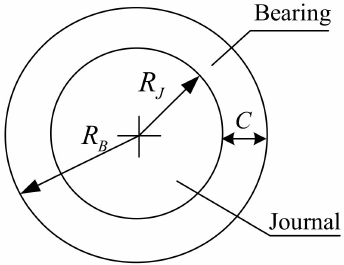
Figure 1. Schematic of revolute joint with clearance.